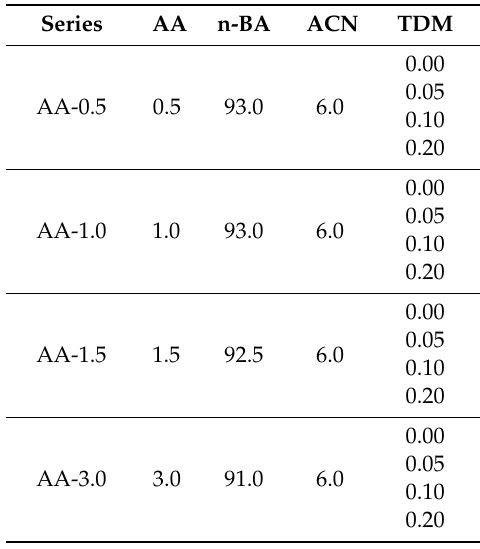
Table 1. Monomer composition (phm): Acrylic acid (AA), n-butyl acrylate (n-BA), acrylonitrile (ACN), and tert-dodecyl mercaptan